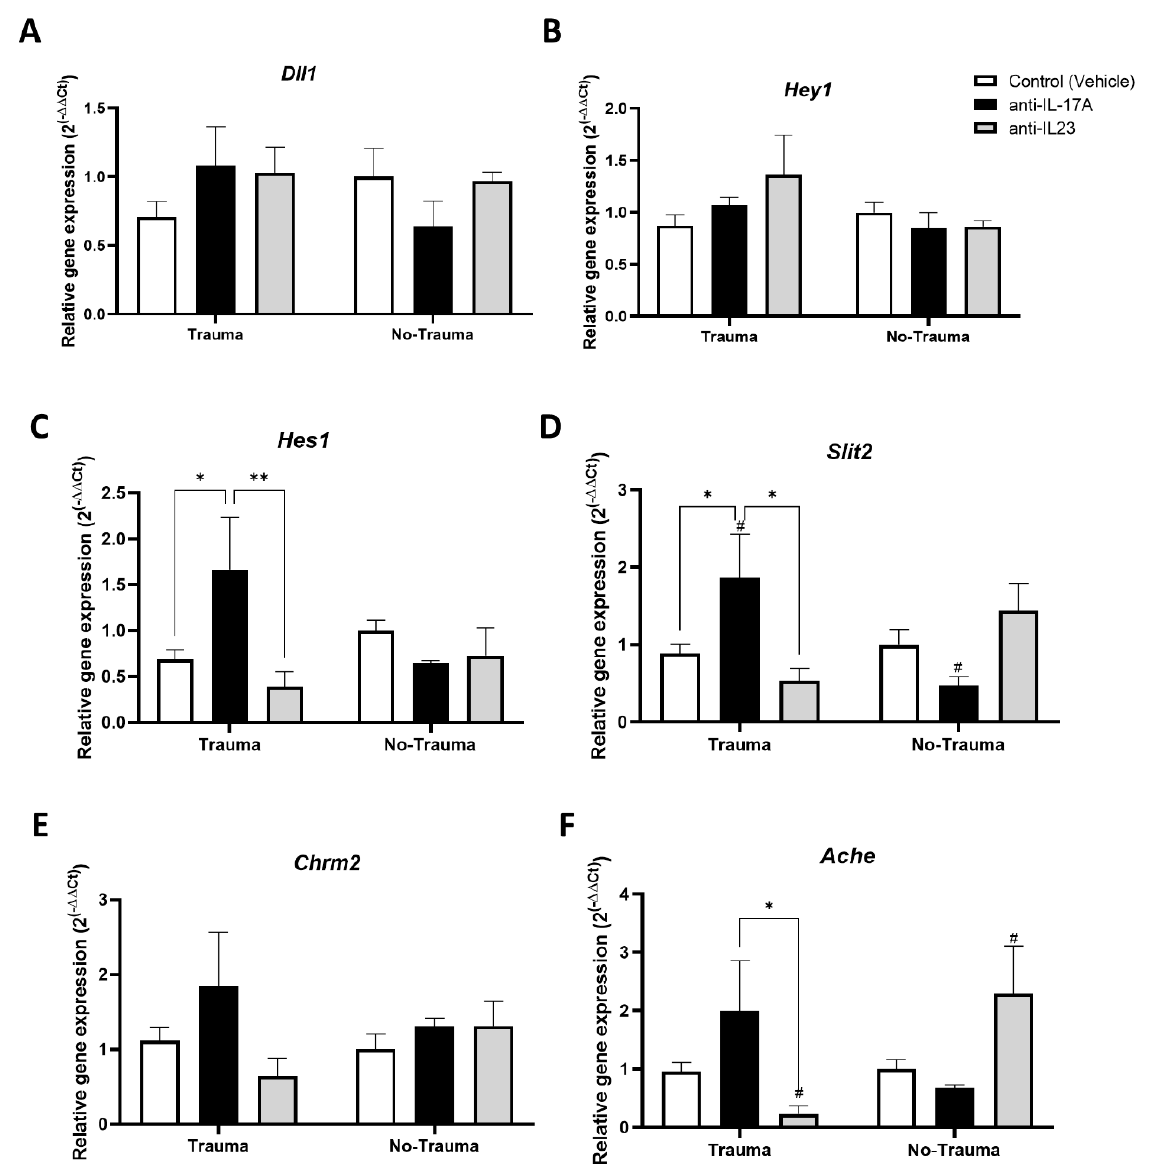
Figure 4. Exposure to trauma and antibody treatment affect hippocampal gene expression. Relative gene expression (2 − ∆∆ CT ) detected by real time PCR performed on hippocampal RNA obtained from mice 2.5 weeks following exposure to trauma, for the following genes: ( A ) Dll1 (Trauma: anti-IL-17A, n = 5. anti-IL-23, n = 5, Control, n = 8. No trauma: anti-IL-17A, n = 4. anti-IL-23, n = 6, Control, n =